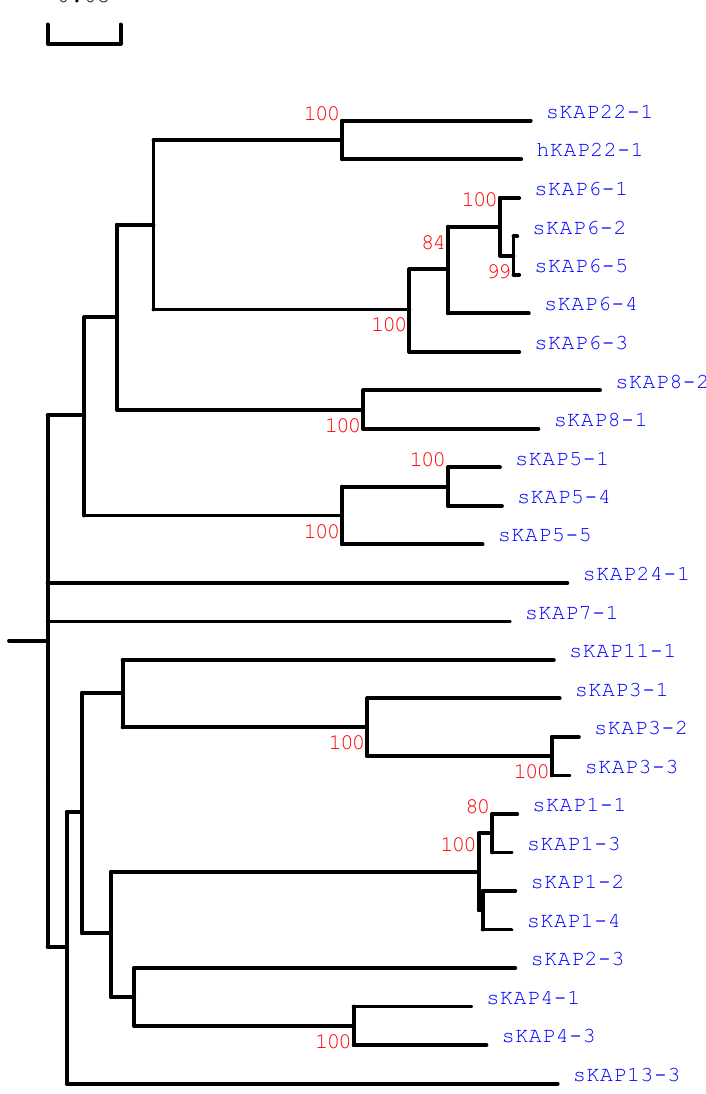
Figure 2. Phylogenetic tree of the sheep genomic regions identified, together with human KAP22 ‐ 1. The tree was constructed using the predicted amino acid sequences. The ovine KAPs are indicated with the prefix “s” and the human KAP has the prefix “h”. The numbers at the forks indicate the bootstrap confidence values and only those equal to or higher than 70% are shown. The GenBank accession numbers for the human KAP22 ‐ 1 is AP001708. The GenBank accession numbers for the sheep KAPs are X01610, HQ897973, X02925, X01610, U60024, M21099, M21100, M21103, X73462, EU239778, X55294, X73434, X73435, M95719, KT725827, KT725833, KT725838, KT725841, X05638, sKAP2 ‐ 3, sKAP3 ‐ 1, sKAP3 ‐ 2, sKAP3 ‐ 3, sKAP4 ‐ 1, sKAP4 ‐ 3, sKAP5 ‐ 1, sKAP5 ‐ 4, sKAP5 ‐ 5, sKAP6 ‐ 1, sKAP6 ‐ 2, sKAP6 ‐ 3, sKAP6 ‐ 4, sKAP6 ‐ 5, sKAP7 ‐ 1, sKAP8 ‐ 1, sKAP8 ‐ 2, sKAP11 ‐ 1, sKAP13 ‐ 3 and sKAP24 ‐ 1, respectively).